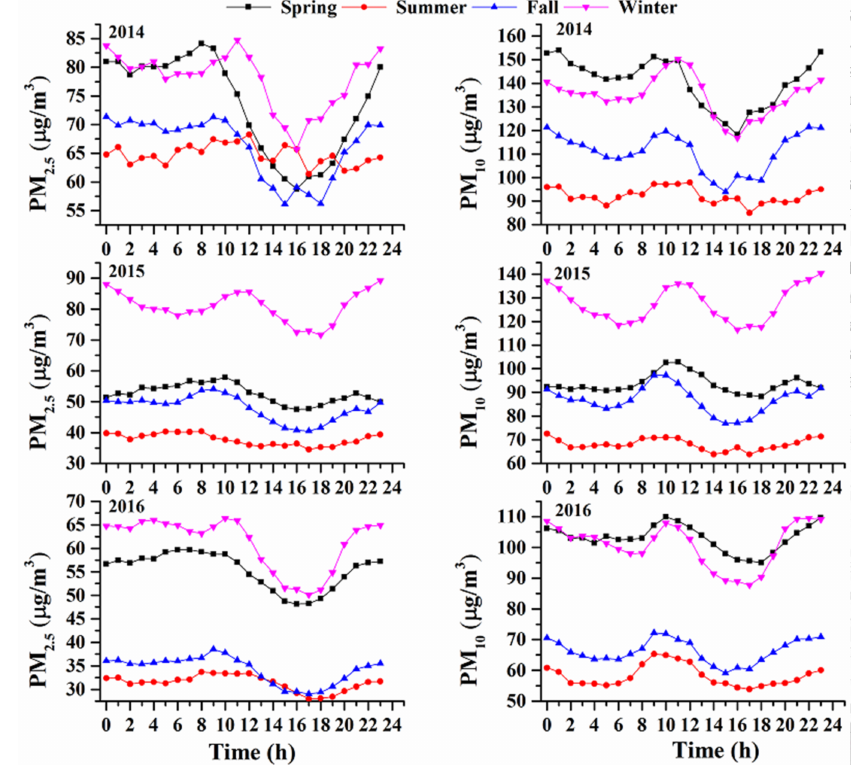
Figure 1. Diurnal variation of hourly PM 2.5 and PM 10 concentrations in 2014, 2015 and